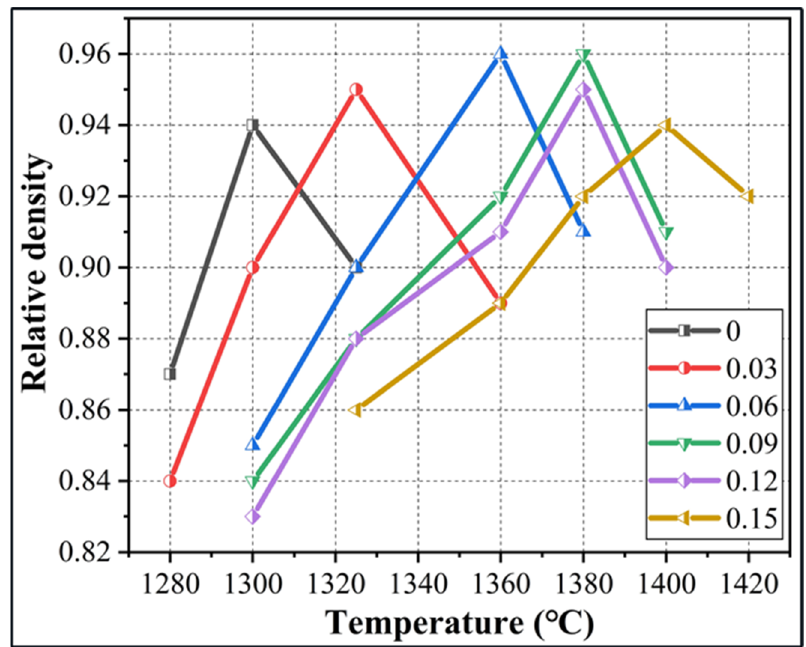
Figure 1. The relative density of the (1 − x )BT- x CSZ ceramics as a function of sintering